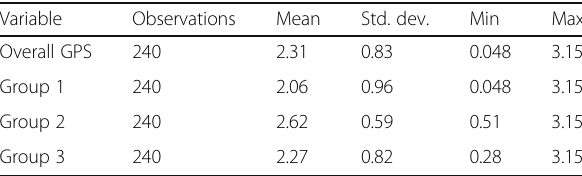
Source: own computation results based on survey data,